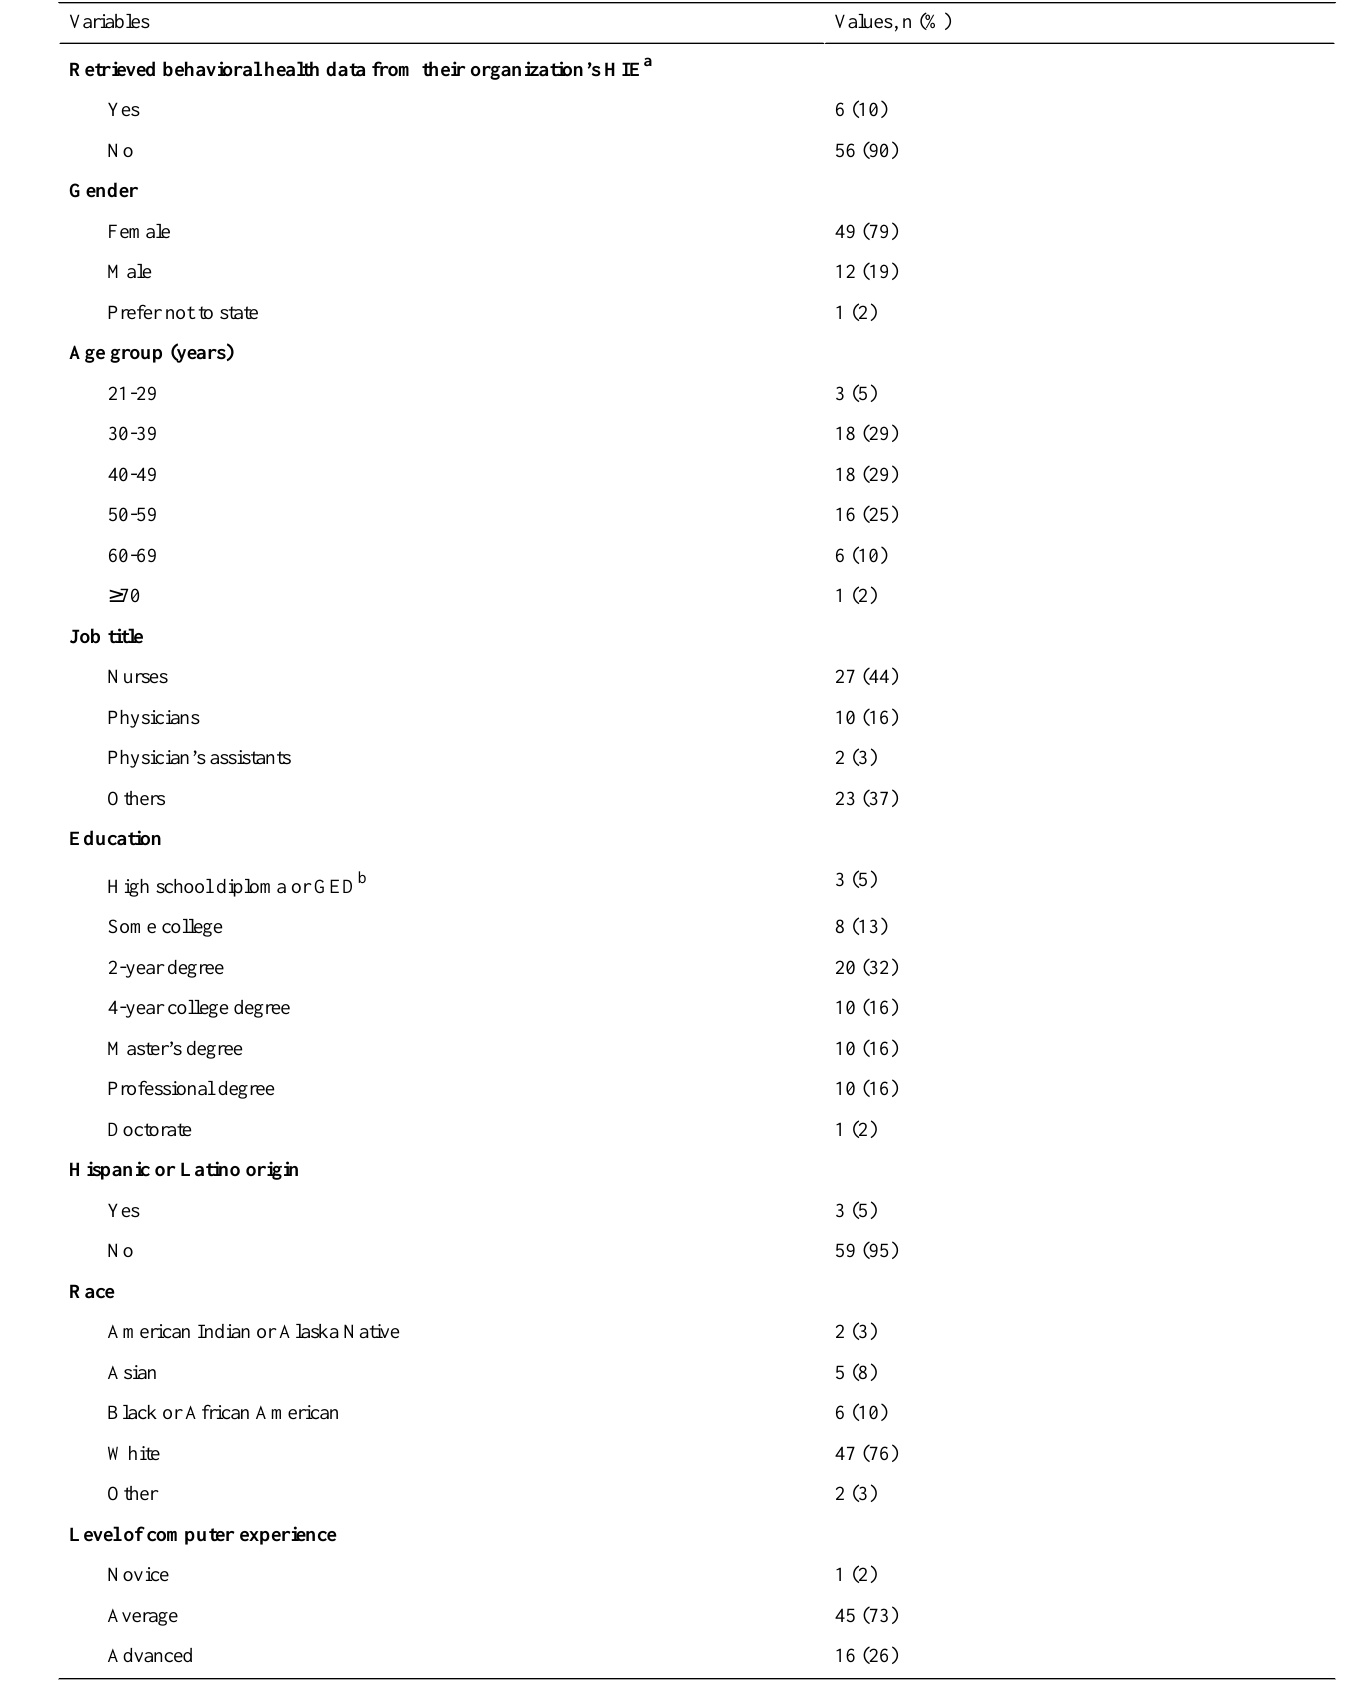
Table 1. Descriptive statistics of behavioral health information exchange survey participants